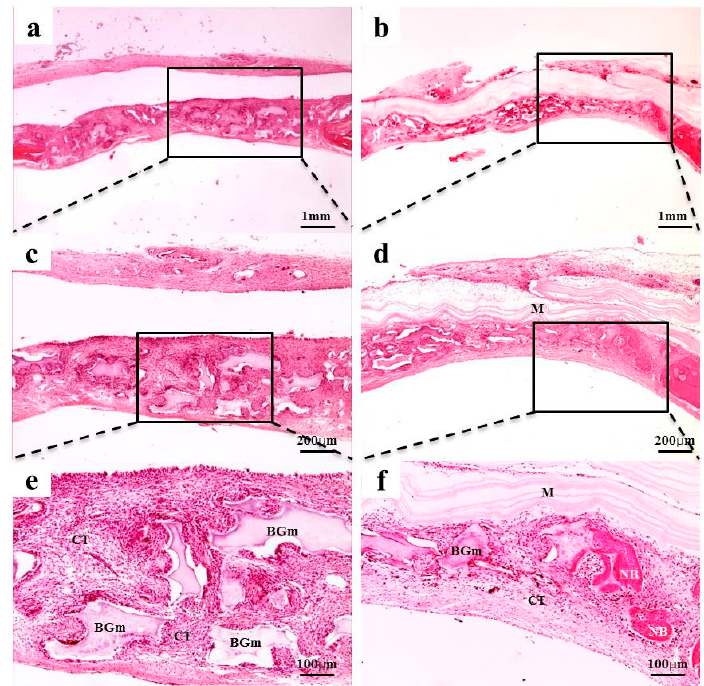
Figure 3. Collagen and 0.10 mm BC membrane. Histological sections of defect sites at 2 weeks after surgery: ( a , c , e ) collagen membrane; ( b , d , f ) 0.10 mm BC. Fibrous connective tissues and bone-like materials were observed in all groups. NB, Fibrous connective tissue; M, membrane; CT, connective tissue; BGm, bone grafting material. Original magnification: ×20 (a,b), ×40 (c,d), ×100 (e,f).